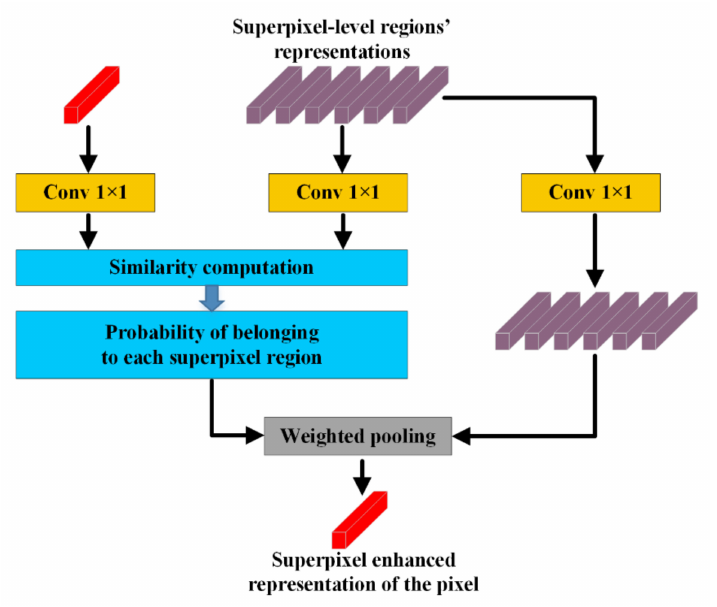
Figure 5. Pipeline of